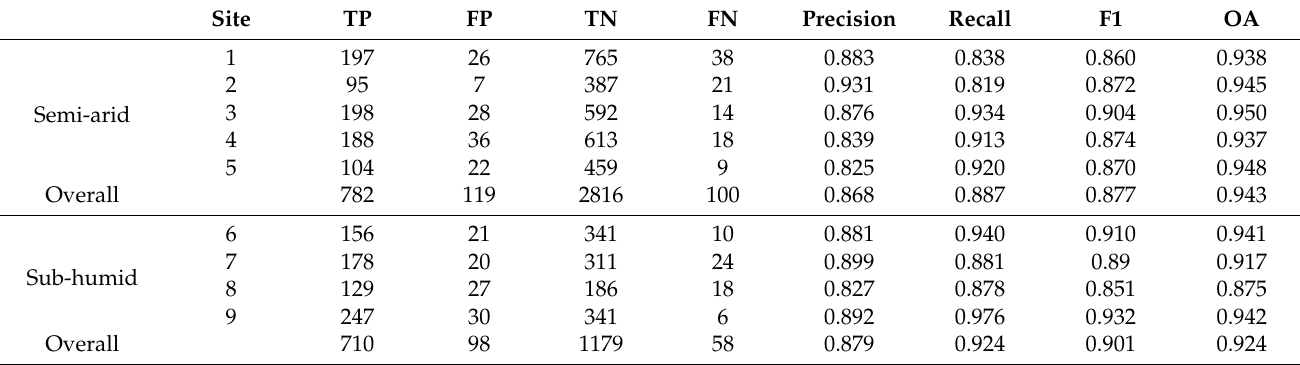
Table 4. Evaluation metrics for olive orchard mapping using grid sampling with DG imagery (TP: true positive, FP: false positive, TN: true negative, FN: false